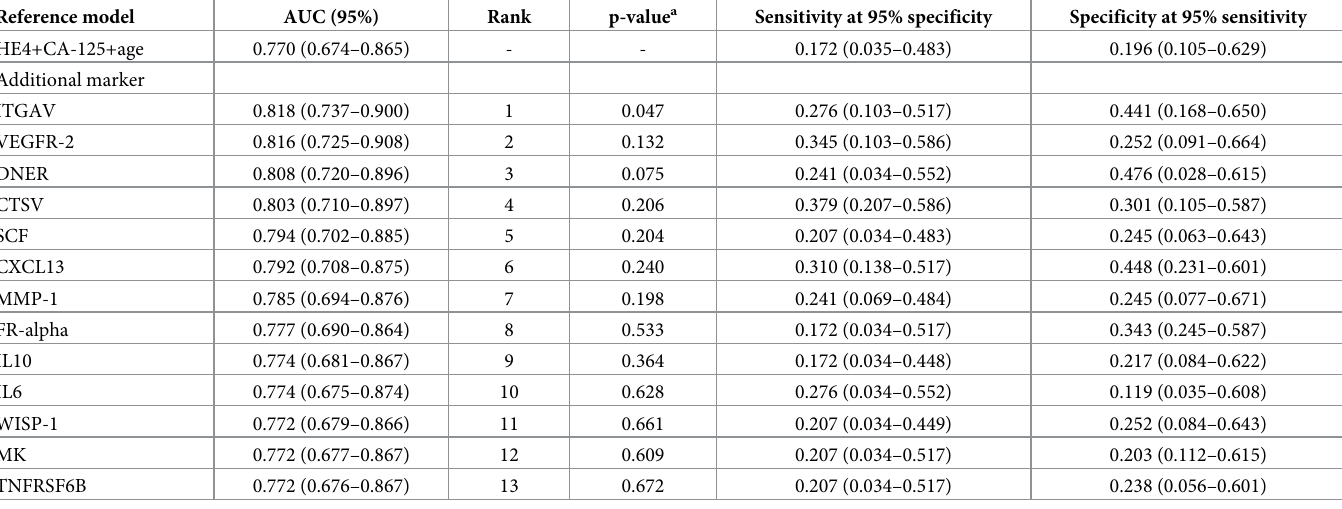
other members of the IL-10-interferon family, including IL-22 [43]. IL-10RB is overexpressed Table 8. Three-biomarker models. Benign tumors vs. borderline +